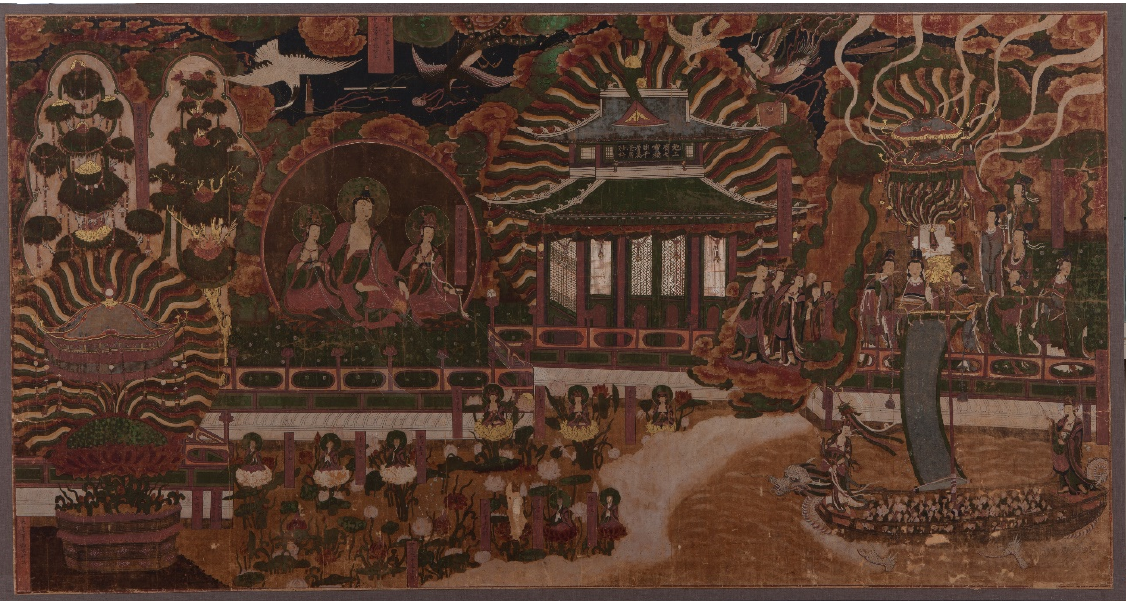
Figure 9. Shortcut to Rebirth through Buddha Mindfulness. Chosŏn, 1750. Colors on silk. 159.8 × 306.5 cm. Ŭnhaesa, Yŏngch’ŏn, North Kyŏngsang Province. Courtesy of the Cultural Heritage Administration.